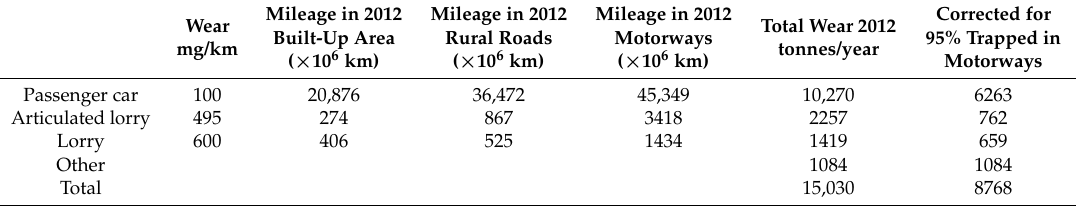
Table 1. Calculation of the amount of tyre wear and tear in The Netherlands by Kole and colleagues [13]. Mileage in 2012 Mileage in 2012 Mileage in 2012 Corrected for Wear Total Wear 2012 Built-Up Area Rural Roads Motorways 95% Trapped in mg/km tonnes/year ( × 10 6 km) ( × 10 6 km) ( × 10 6 km) Motorways Passenger